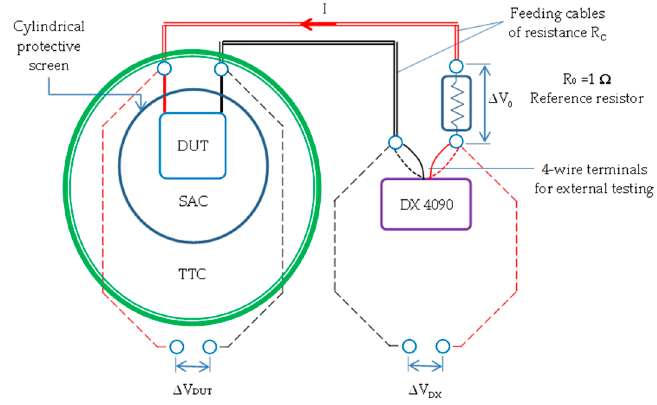
Figure 1. Scheme of the experimental arrangement. DX 4090 is the z-meter, TTC is the Thermostatic Test Chamber, SAC is the Still Air Chamber, and DUT is the Device Under Test. Solid and double red and black lines are the feeding cables, while the dashed ones represent the signal wires.